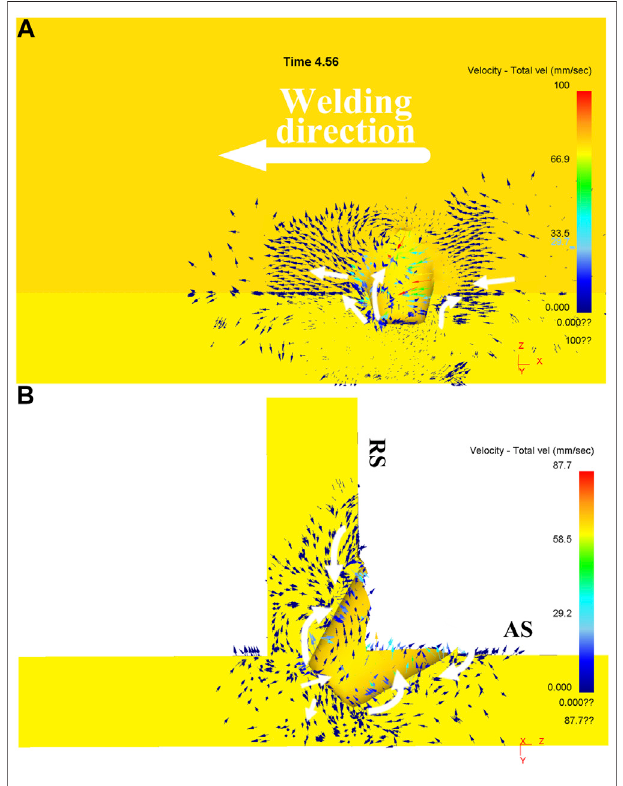
FIGURE 9 | Metal fl ow in the weld (A) Along the welding direction (B) Vertical welding direction.